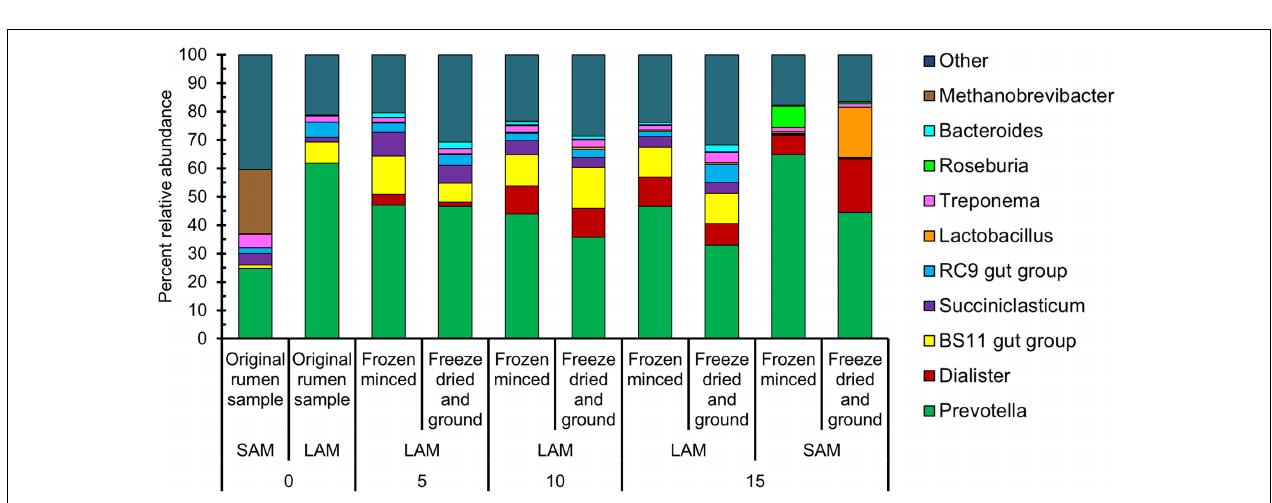
FIGURE 1 | Production of the volatile fatty acids (A) acetate, (B) caproate, and (C) valerate, by experimental day and forage preparation type. Error bars represent standard error of the mean. Forage preparation types that significantly differ ( P < 0.05) within each experimental day are indicated by different uppercase letters.